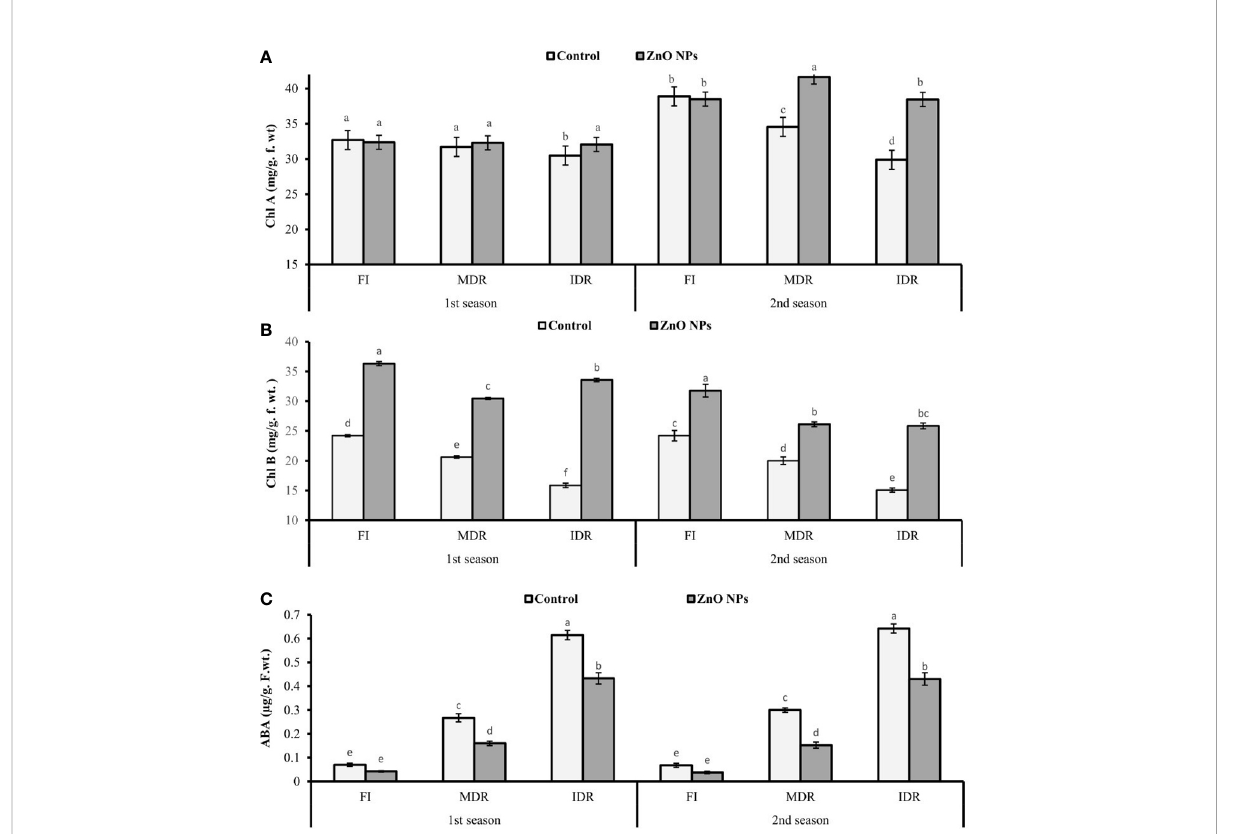
FIGURE 2 Effect of foliar application of ZnO nanoparticles (100 ppm) on (A) Chl a (chlorophyll a), (B) Chl b (chlorophyll b), and (C) abscisic acid content in the fi rst and second seasons in full irrigation, moderate drought regimes, and intensive drought regime plants. The graph values are the mean ± SE of four replicates. Bars exhibited with different alphabets indicate the signi fi cant difference between samples by least signi fi cant difference ( p ≤